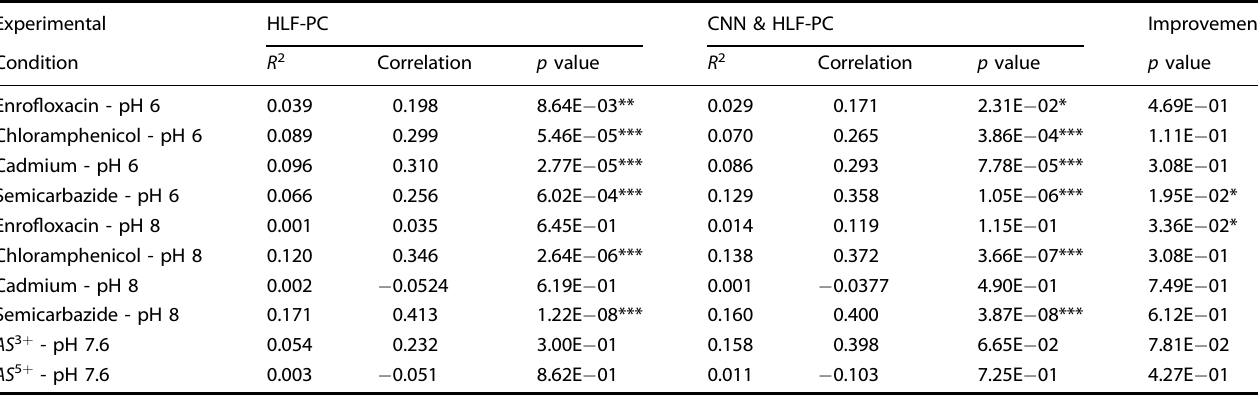
Table 1. GBDT out-of-sample predictive power for each experimental condition.